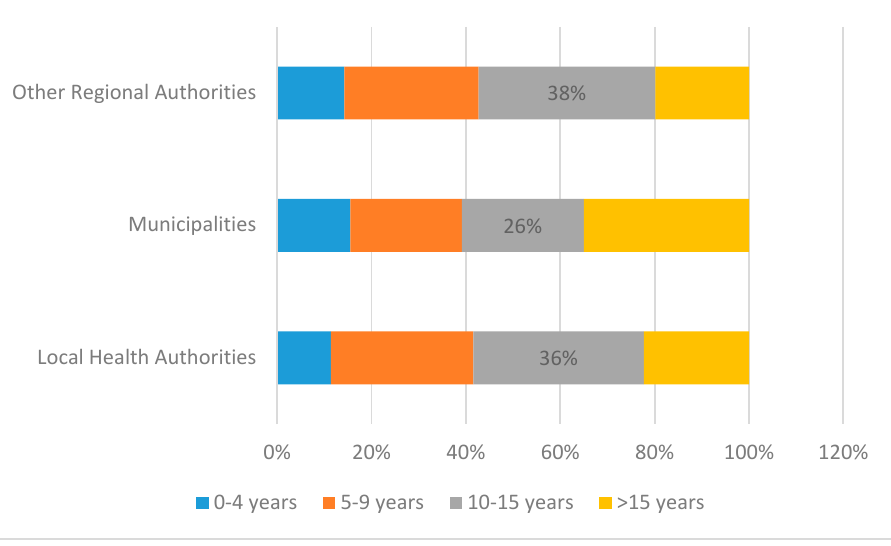
Figure 1. Age distribution of the vehicles.